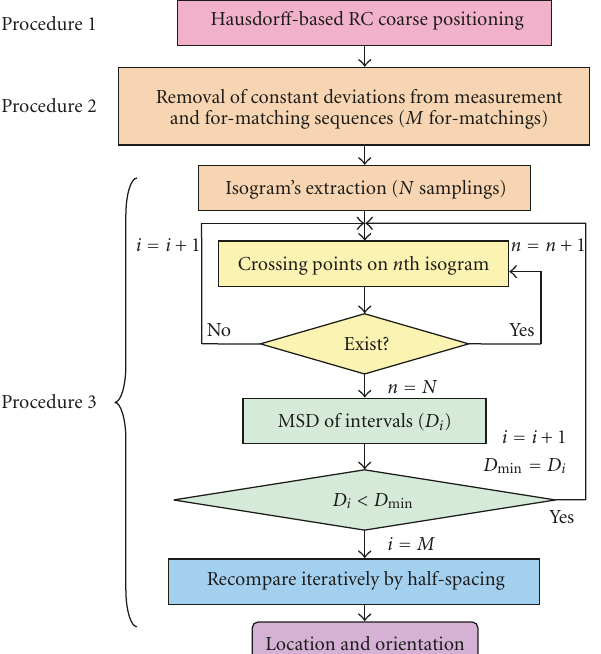
Figure 4: Workflow of the combination algorithm for UMN.